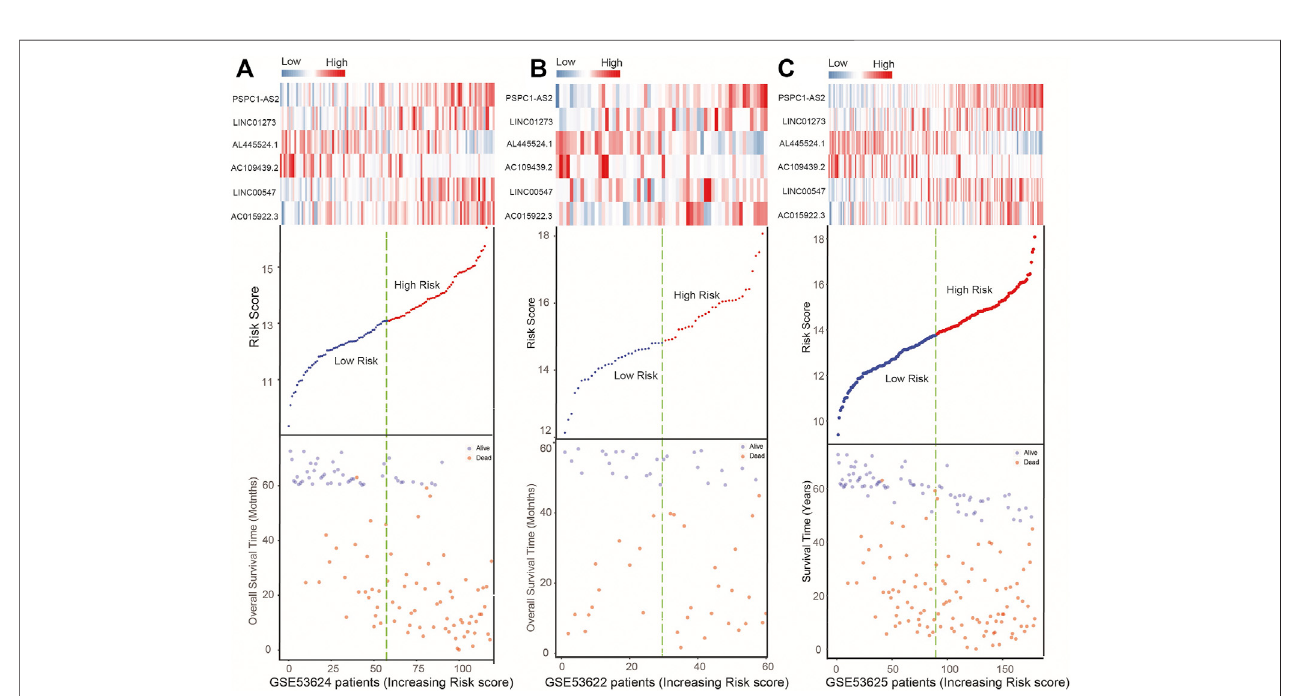
FIGURE 3 | Expression heatmap of the six lncRNAs, plot of six-lncRNA risk scores, and ESCC patient ’ s survival status in the GSE53624 (A) , GSE53622 (B) , and GSE53625 (C) datasets.